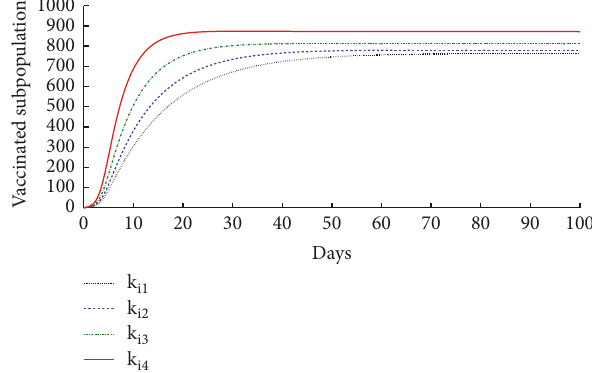
Figure 11: Evolution of the vaccinated subpopulation for different values of 𝑘 𝑖 .